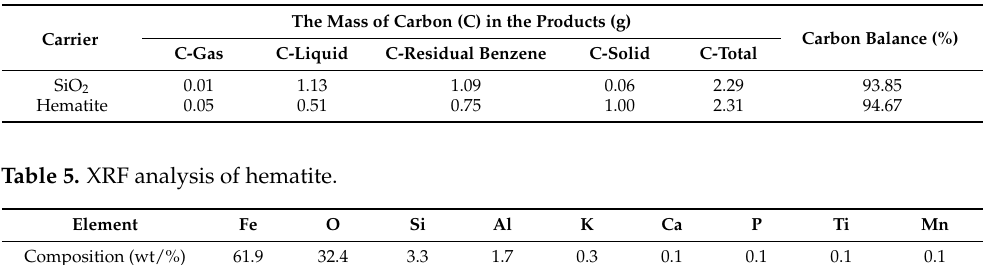
Table 4. Distribution of carbon-containing species in the products.